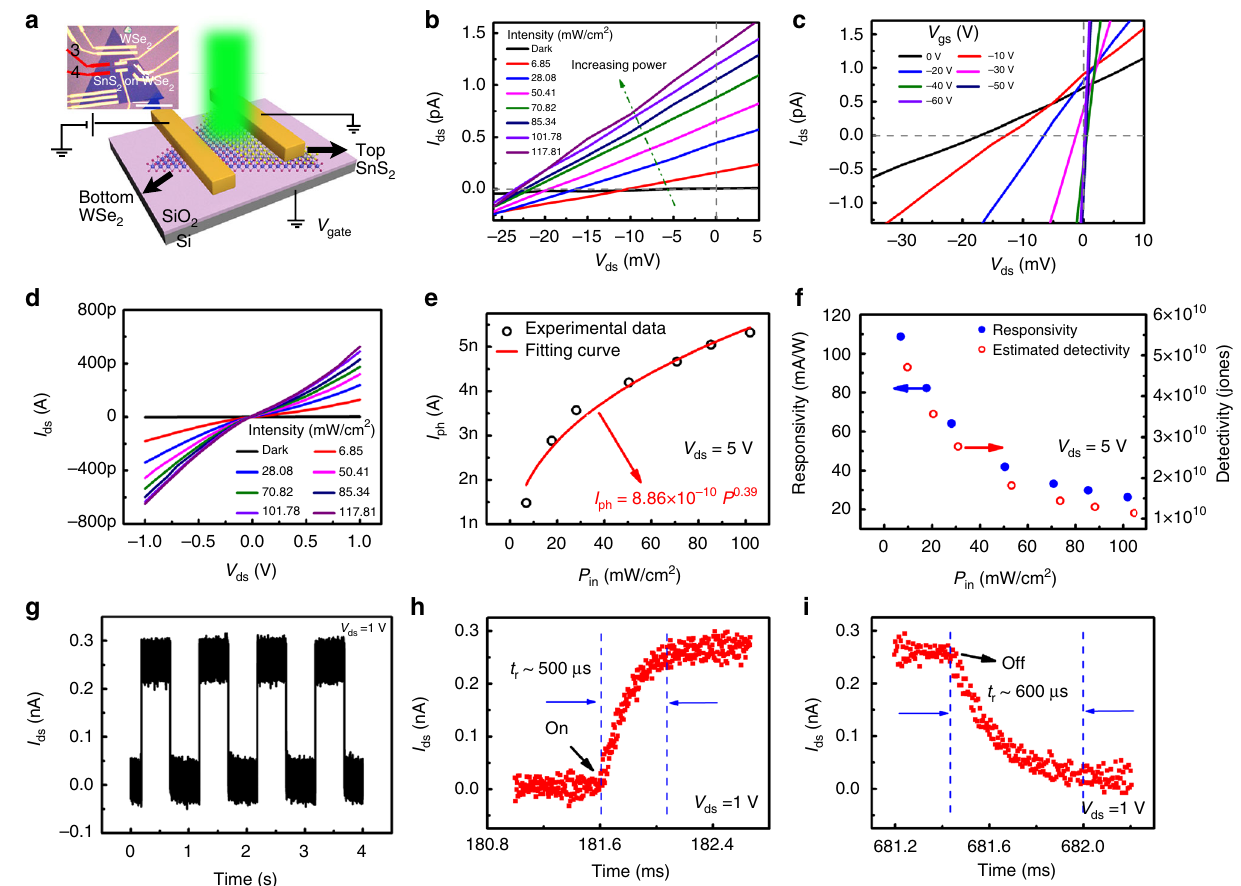
Fig. 5 Optoelectronic characterization of the parallel-series mode WSe 2 /SnS 2 heterojunction. a A cartoon schematic of the parallel-series mode WSe 2 /SnS 2 vdW heterojunction photodetector. Inset is an optical image of the heterojunction device. (measured using electrodes 3 and 4, see Fig. 4c). b I ds − V ds curves across the p – n junction under 520 nm laser illumination at different incident power. c I ds − V ds curves at various backgate voltages from − 60 V to 0 V under 520 nm laser illumination at fi xed 101 mW cm − 2 power intensity. d I − V – n junction under 520 nm laser ds ds curves across the p illumination at different incident power. V ds range from − 1 V to 1 V. e Dependence of photocurrent on illumination power intensities. f Photoresponsivity and detectivity of the photodetector at various illumination power intensities. g Photocurrent response of the device, the laser light is turned on/off by a chopper worked at 1 Hz (520 nm, 101 mWcm − 2 , V ds = 1 V). h , i Time-resolved photoresponse of the device, namely the rise and fall times of the photocurrent measured at V ds = 1